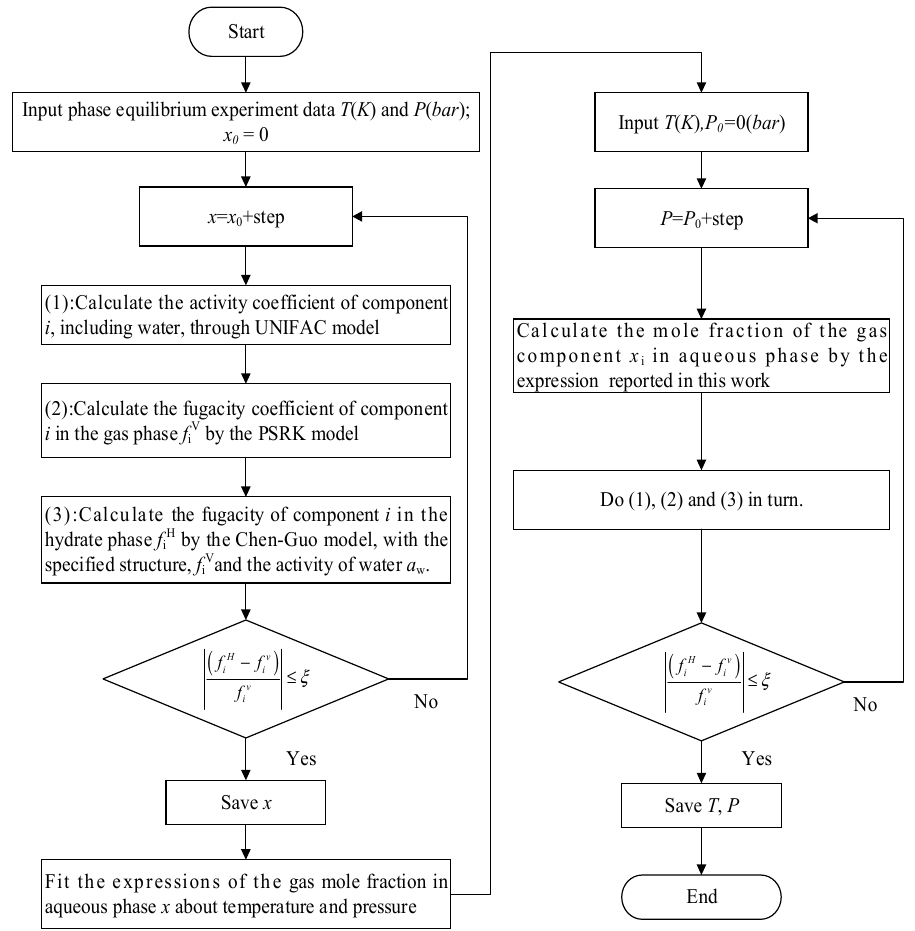
Figure 1. Calculation procedure for the prediction of phase equilibrium pressures at given temperatures.